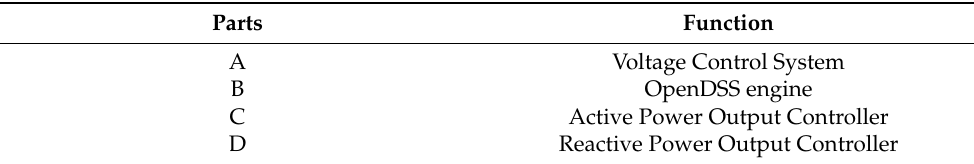
Table 2. MATLAB/Simulink model functions.